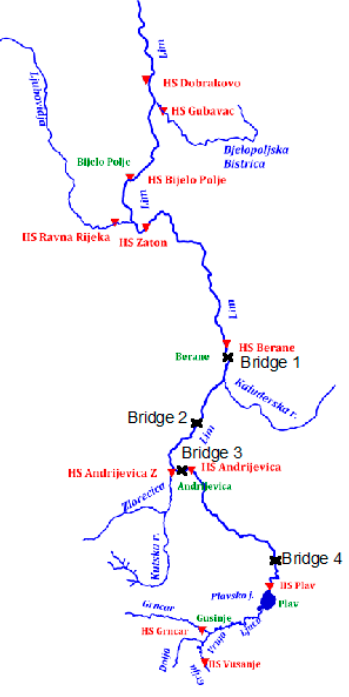
Figure 1. Lim River with positions of damaged bridges.